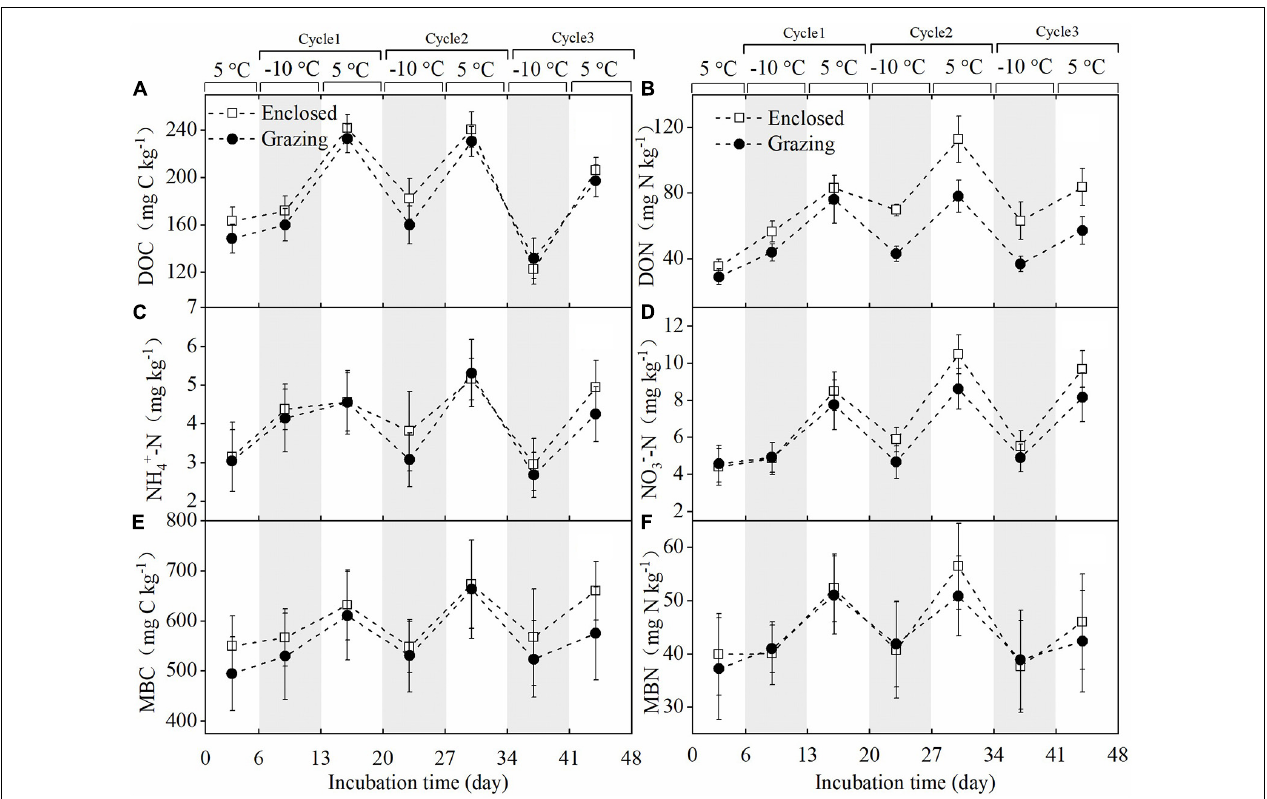
FIGURE 1 | The dynamics of soil DOC (A) , DON (B) , NH 4 + -N (C) , and NO 3 - -N (D) contents and microbial biomass C (E) and microbial biomass N (F) during FTCs (mean ± SE, N = 9). The gray areas indicate the freezing periods.